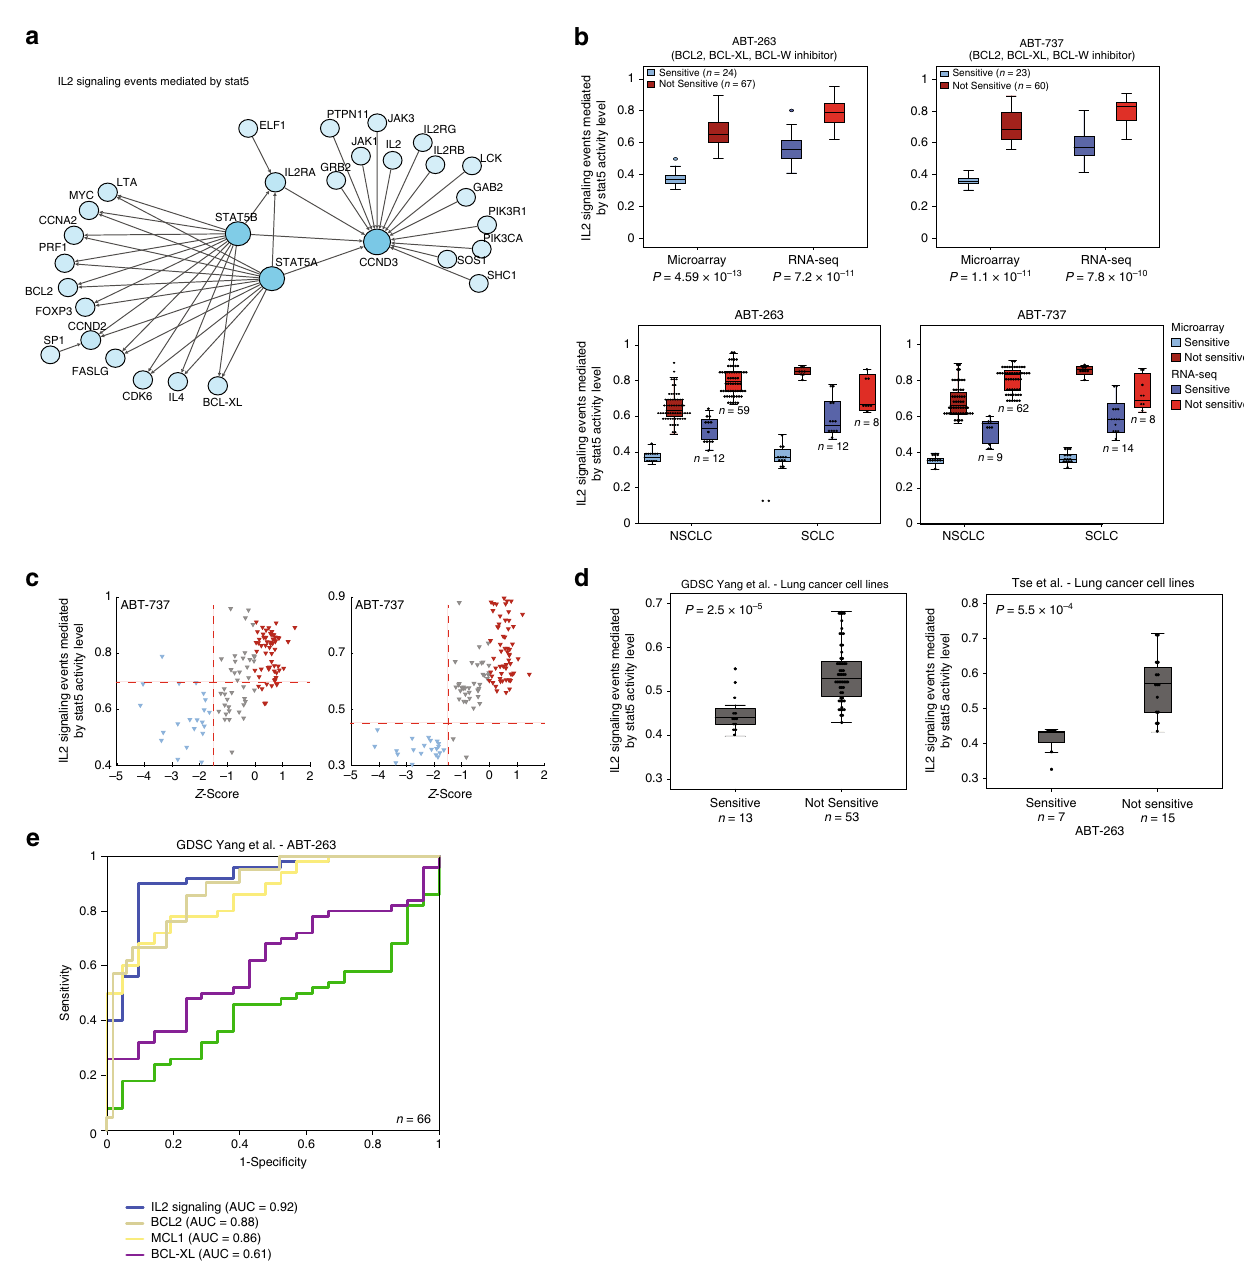
Fig. 2 IL2 – STAT5 pathway predicts response to BCL2 inhibitors. a Network diagram representing the ‘ IL2 signaling events mediated by STAT5 ′ pathway. b IL2 – STAT5 pathway activity levels in sensitive and not-sensitive lung cancer cell lines in microarray and RNA-seq. Upper box plots represent all lung cancer cell lines, and lower box plots represent the SCLC and NSCLC subtypes. Error bars represent the standard deviation. P -values were generated using Mann – Whitney U -test. c Scatter plot of ABT-737 AUC z -score values versus IL2 – STAT5 pathway levels in microarray and RNA-seq (blue: sensitive cell lines; red: not-sensitive cell lines; gray: samples that were excluded from the analysis). d Two independent datasets of lung cancer cell lines treated with ABT-263. Box plots show IL2 – STAT5 pathway activity levels in sensitive and not-sensitive cell lines. Error bars represent the standard deviation. P -values were generated using Mann – Whitney U -test. e ROC analysis was constructed to evaluate the prognostic power of the IL2 – STAT5 pathway versus ABT- 263 targets and MCL1 in the validation set. The AUC was used to quantify response prediction. See also Supplementary Fig.